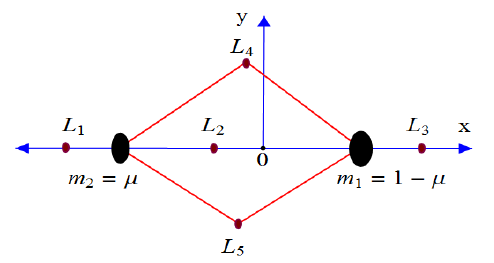
Fig. 2 The positions of the equilibrium points L i : i = 1 ,...,